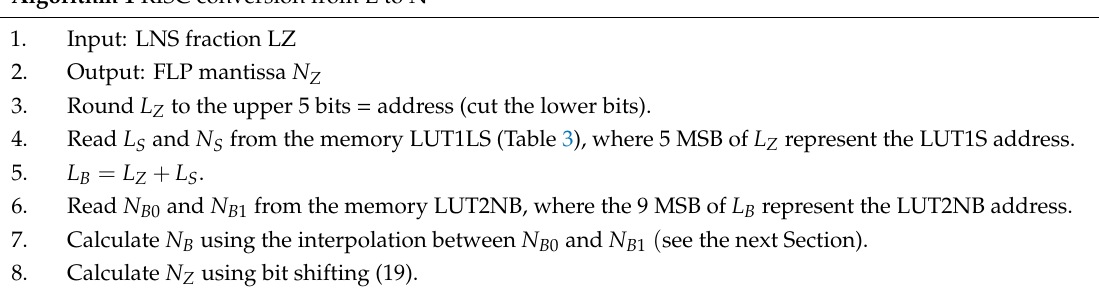
Algorithm 1 RISC conversion from L to N